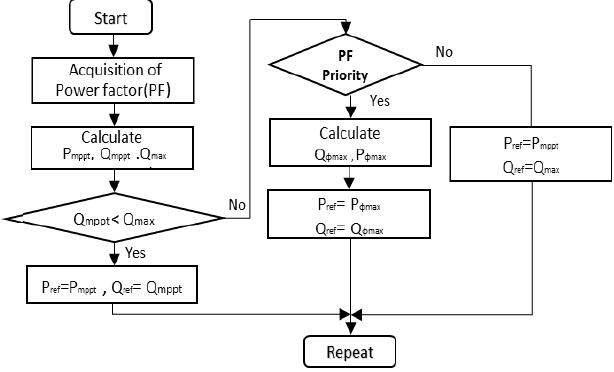
Figure 5 . The proposed Reactive Power management